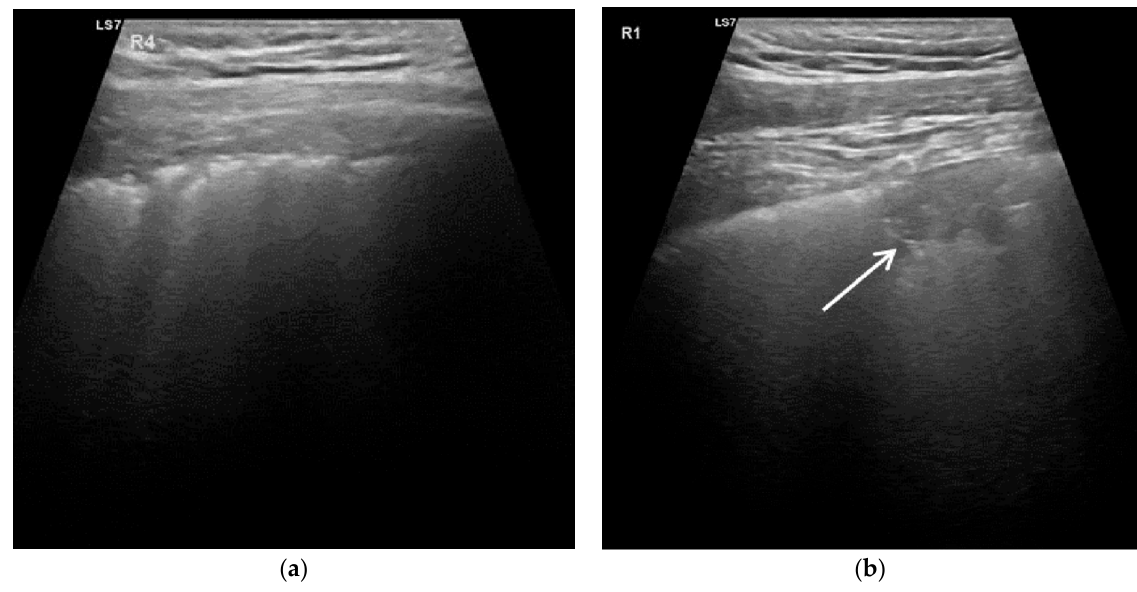
Figure 2. Lung ultrasonography image of a patient with COVID-19 disease: ( a ) pronounced fragmentation of the pleural line and small subpleural consolidations (according to LUS score 2) and ( b ) lung ultrasonography image of a patient with COVID-19 disease. Thickened pleural line with irregularity and a large consolidation with air bronchogram (arrow; according to LUS score 3). Corresponding video frames are available online (Supplementary Videos S1 and S2).